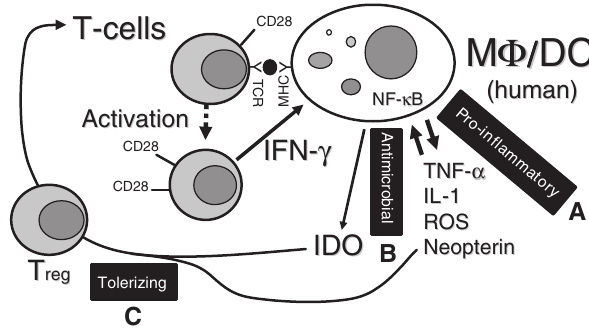
Figure 7 Th1-type immune response and induction of